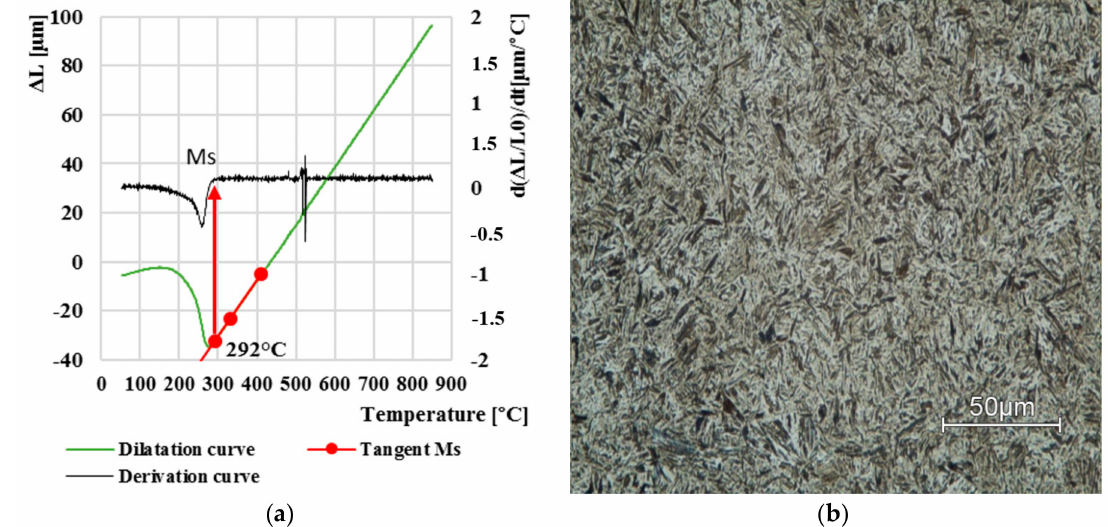
Figure 6. Dilatation curve ( a ); the final microstructure LOM ( b ) after cooling at 0.5 ◦ C · s − 1 . ◦ − 1 Lastly, we examined the dilatation curve at cooling of 0.01 C · s , which can be observed in Figure 7a. Up to three phase transformations occurred in this resulting structure, namely, ferritic, ◦ bainitic and martensitic. The ferritic began at 700 C. Subsequently, a bainitic transformation ◦ ◦ began at temperature of 476 C. The start of the martensitic transition did not occur until 158 C. Final microstructure comprised bainite matrix with polygonal ferrite and a very small amount of martensite (Figure 7b).